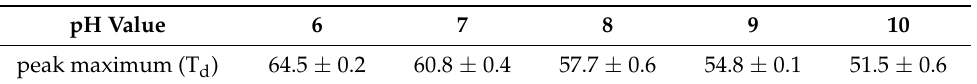
Table 1. Values of the peak maximum of denaturation peaks obtained through mDSC experiments. PPI samples were heated with 2 ◦